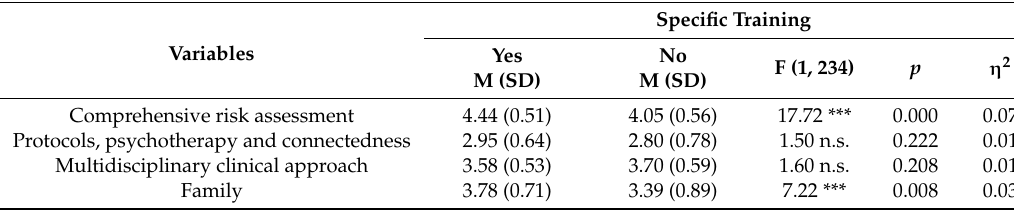
Table 4. Differences on practices according to